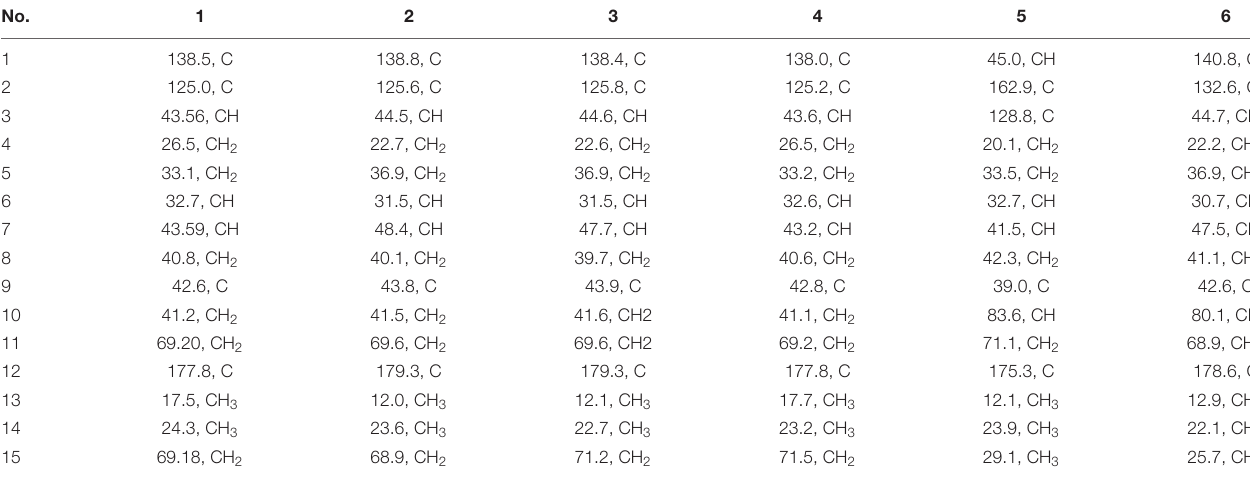
TABLE 2 | 13 C NMR data of compounds 1 – 6 in CDCl 3 at 150 MHz.